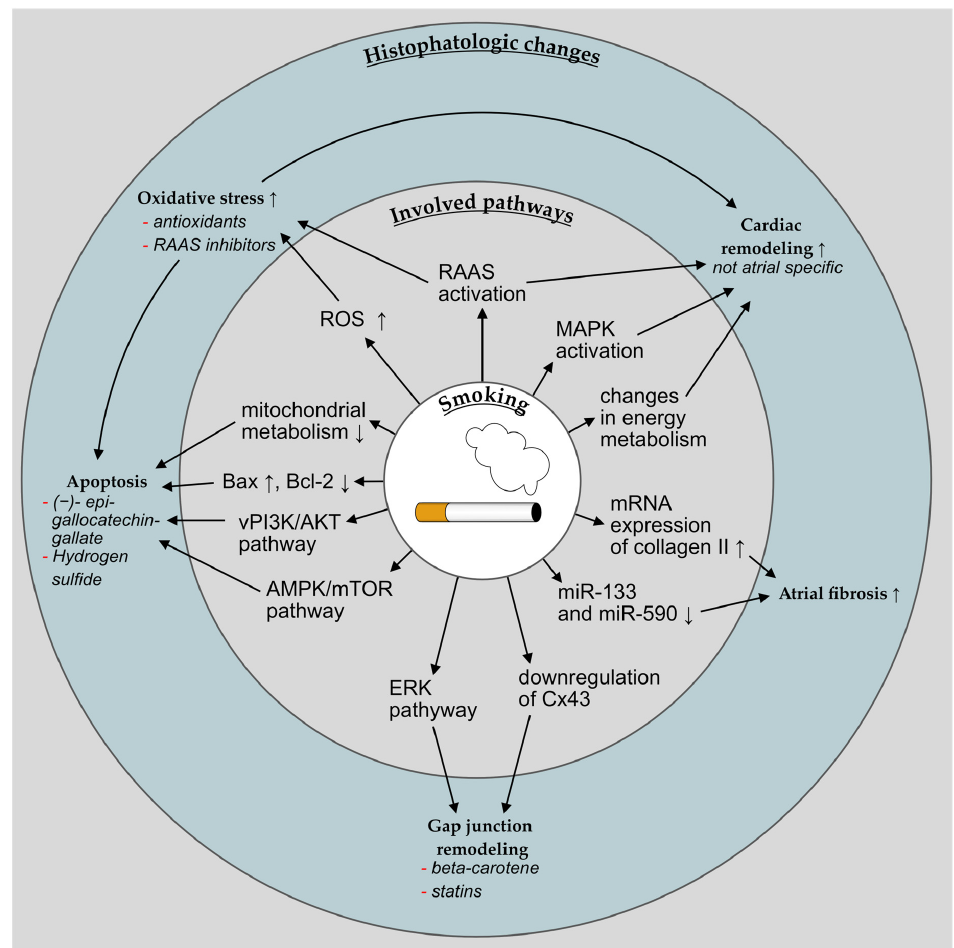
Figure 3. Simplified overview over the histopathologic changes in the atrium that are associated with smoking and the involved pathways. ↑ indicates an increase and ↓ a decrease of the respective aspect, —an attenuation of a certain